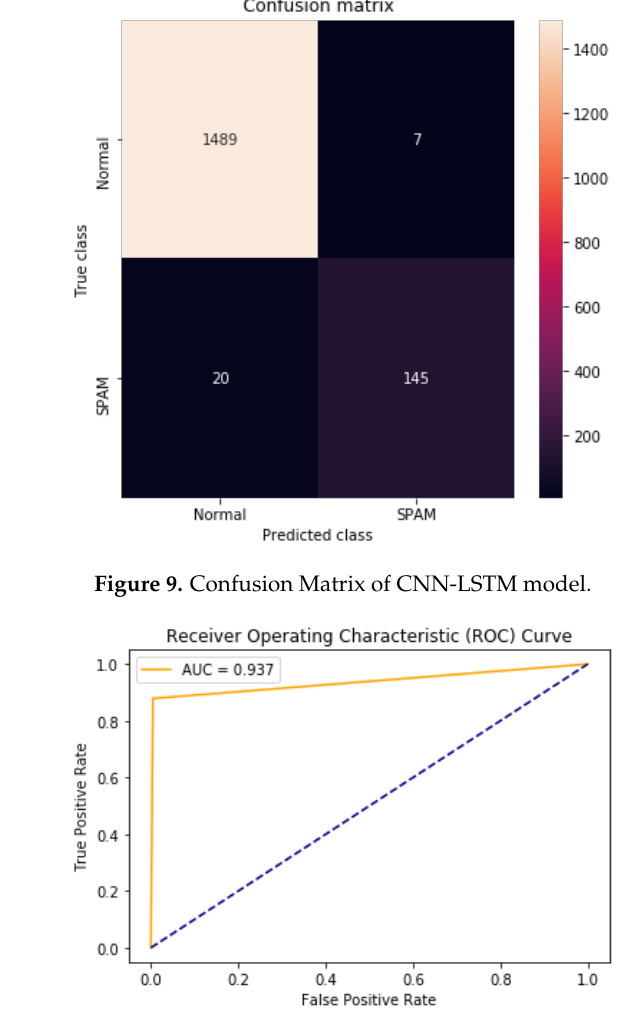
Figure 10. ROC curve of CNN-LSTM